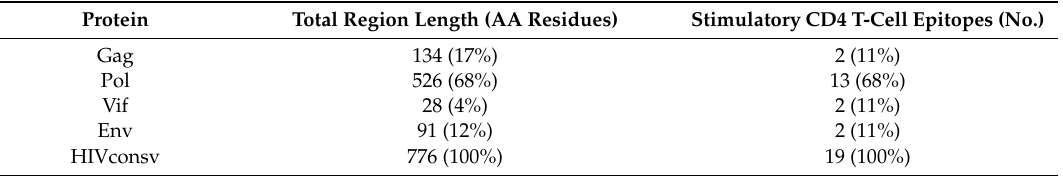
Table 3. Correlation between stimulatory CD4 + T-cell epitopes and HIVconsv protein proportion. Protein Total Region Length (AA Residues) Stimulatory CD4 T-Cell Epitopes (No.) Gag 134 (17%) 2 (11%) Pol 526 (68%) 13 (68%) Vif 28 (4%) 2 (11%) Env 91 (12%) 2 (11%) HIVconsv 776 (100%) 19